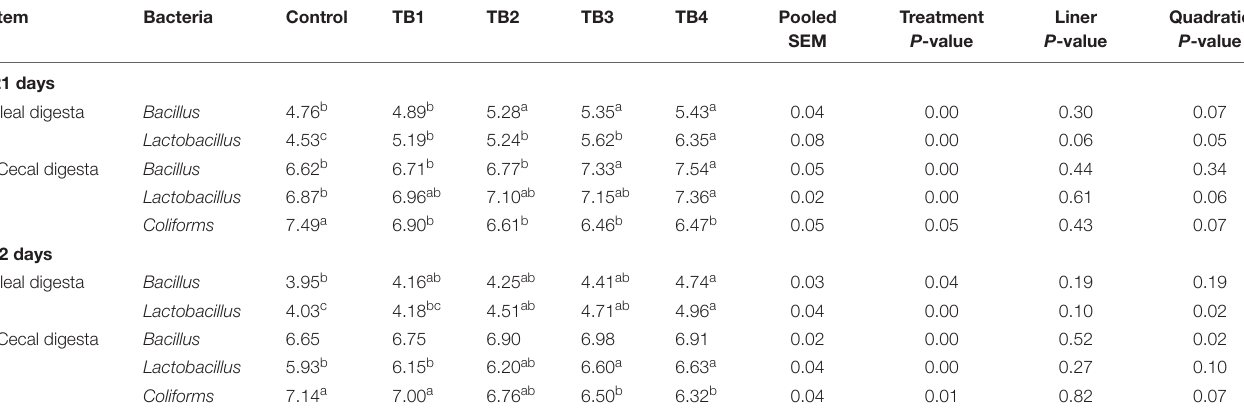
TABLE 4 | Effect of dietary TB on ileal and cecal bacterial populations (log10 CFU/g fresh digesta) in broilers. Item